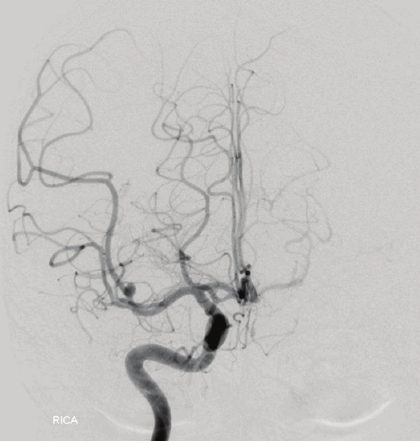
Figure 6: MRI-GE image scan 24 hours after Onyx embolization showinganareaoflowintensityatthesiteofembolicmaterialwithin the aneurysm without ischemic complication.